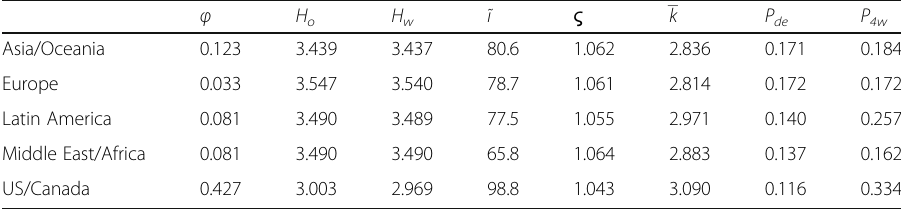
Table 2 Mean values of indicators aggregated by world region φ Η o Η w ĩ ς k ̅ P de P 4w Asia/Oceania